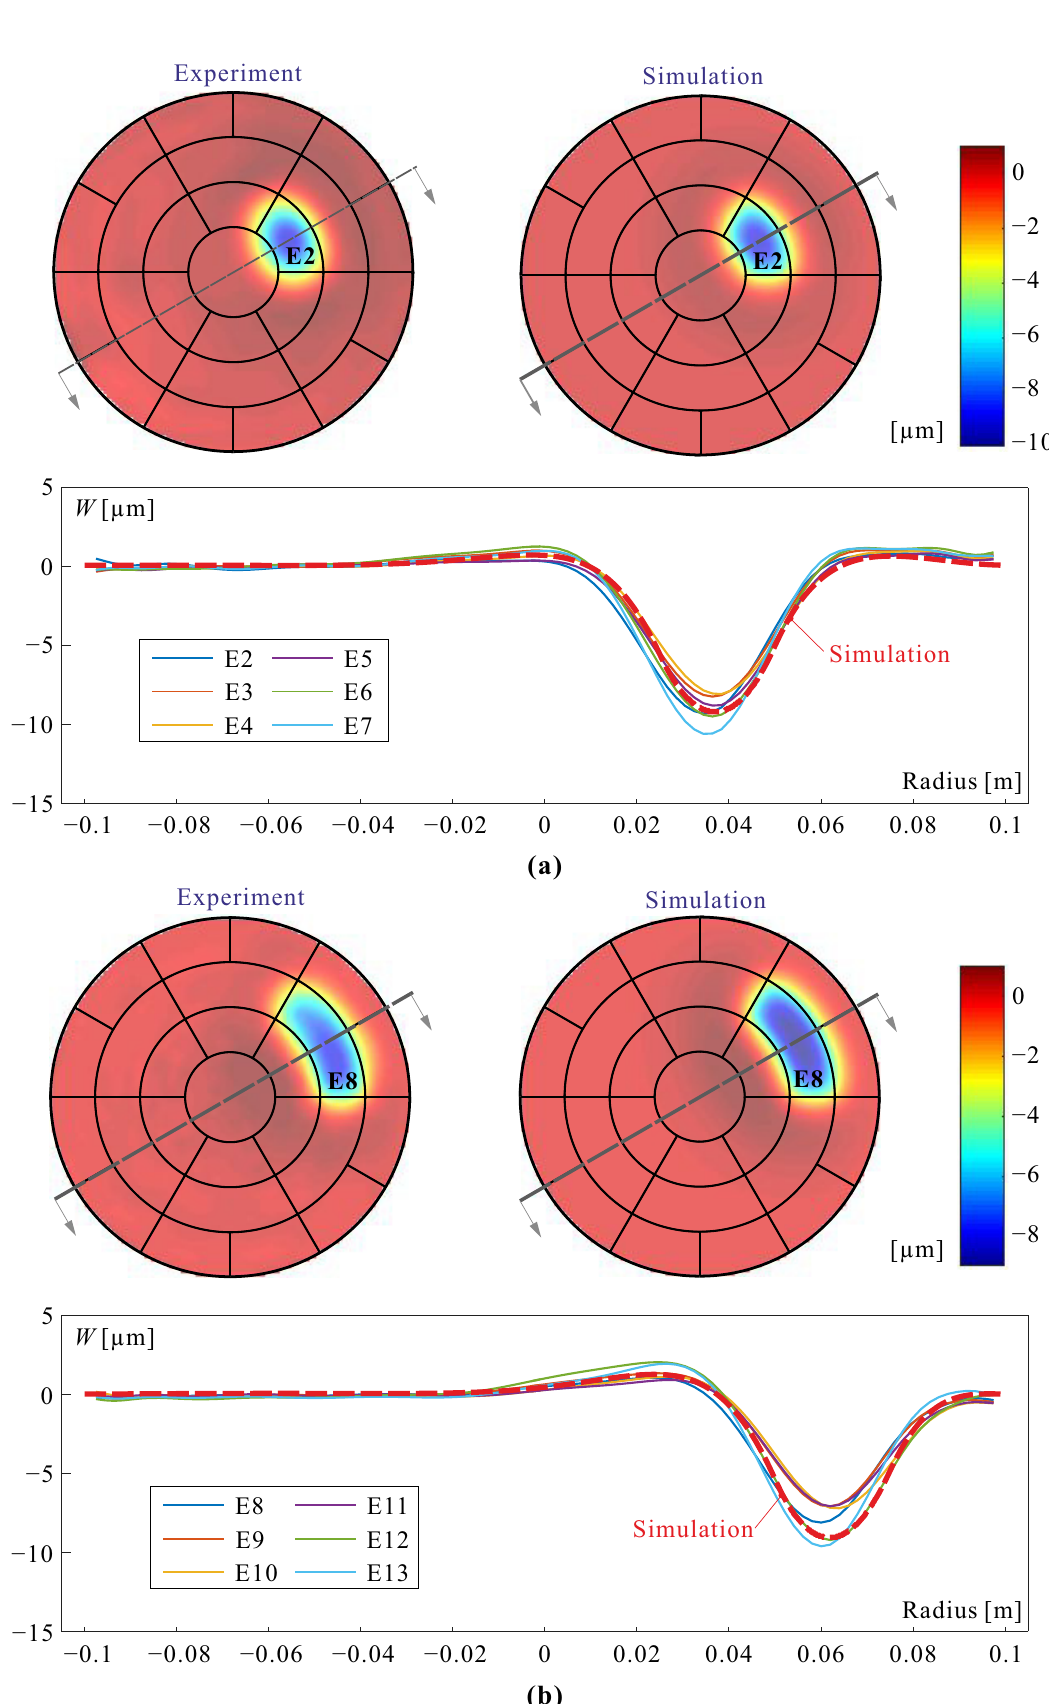
Figure 6. Comparison between experimental 45 ◦ cross sections of the influence functions of the six electrodes of the same row (order: 2 and 3) and a numerical simulation with d 31 = 10